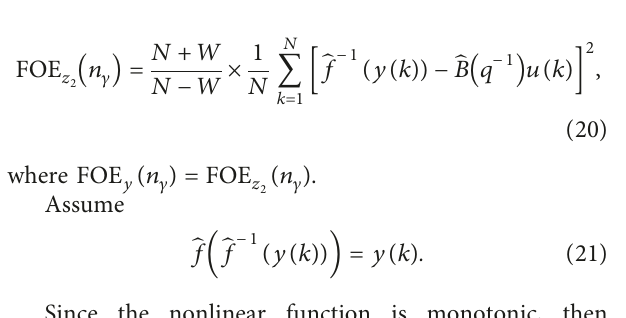
A LGORITHM 1: Pseudocode of M-H sampling